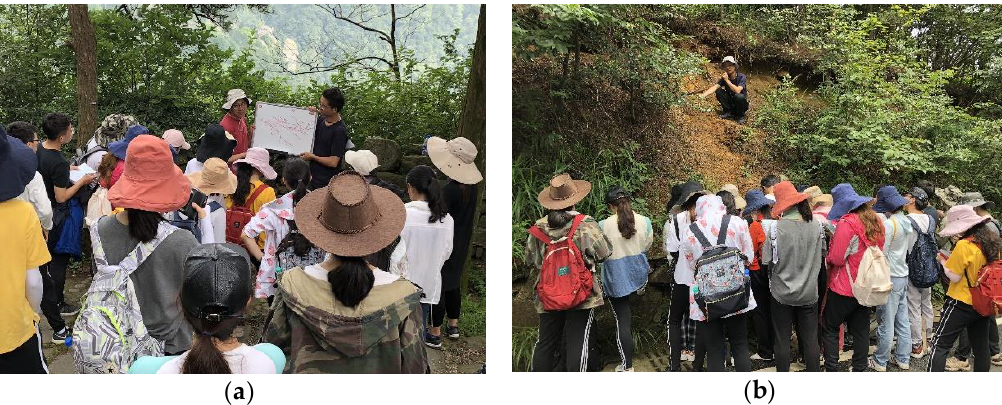
Figure 1. Typical fieldwork scenes in China. ( a ) A teacher leads many students to explain the observation point's content, and students cannot see the pen tablet in the teacher's hand.; ( b ) The teacher is explaining soil stratification.